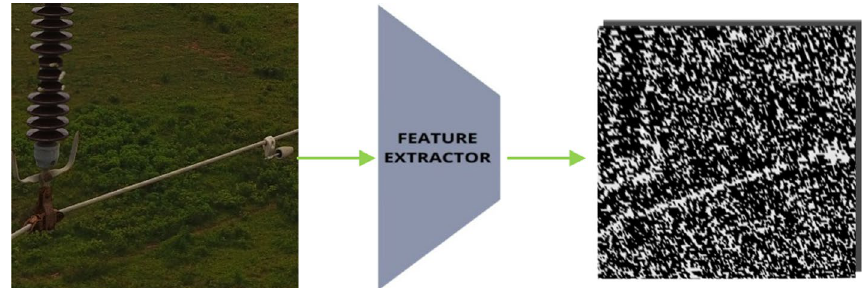
Fig. 8 Input image patch and corresponding feature map generated by the feature extractor (backbone architecture)